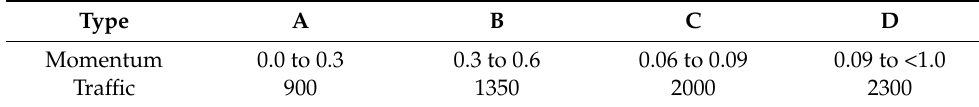
Table 4. Rank of Service calculation based on